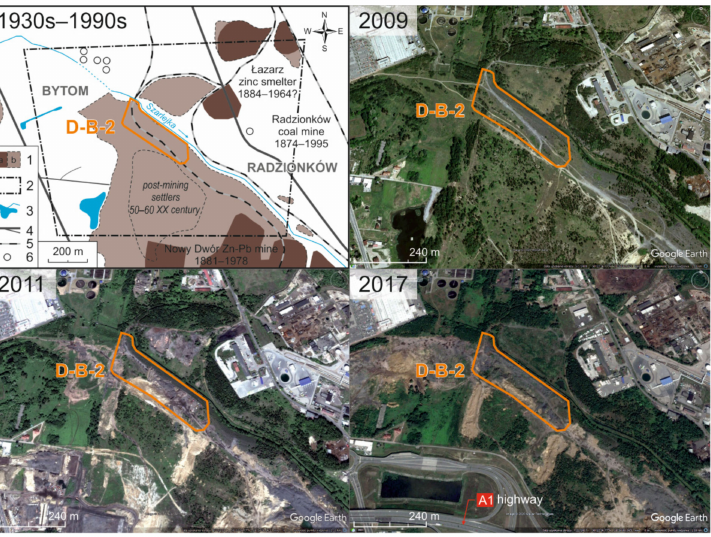
Figure 3. Historical cartographic data for the dump D-B-2: 1: waste dumps (a: 1930s and b: 1990s), 2: orthophotomaps range, 3: surface water in the 1990s, 4: roads in the 1990s, 5: railways in the 1990s, and 6: other landmarks in the